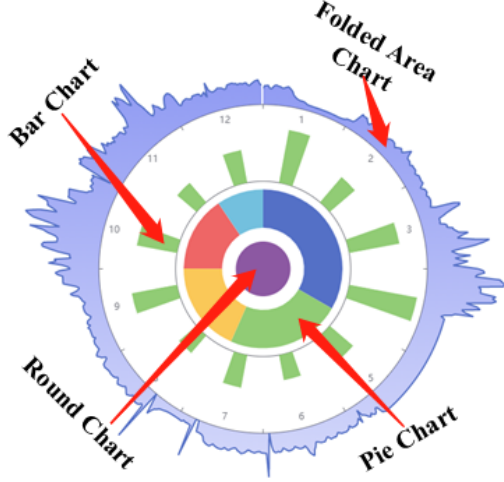
Figure 3. Graphic design structure.